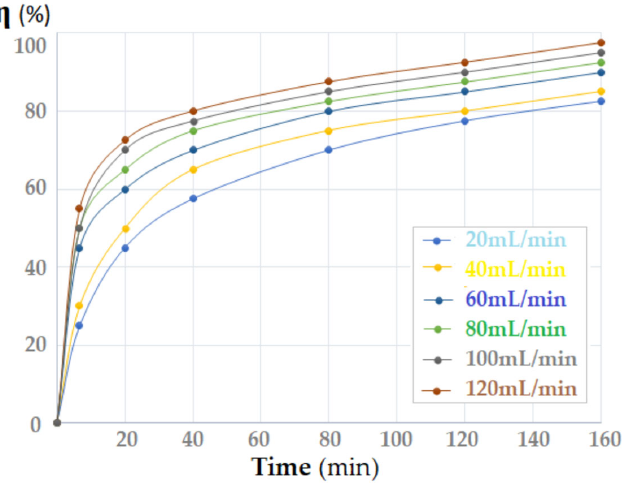
Figure 12. The variation in p –nitrophenol conversion ( η ) depending on the flow rate of the source phase (1000 mL) and the contact time with the membrane phase, containing 1.0 g/L osmium nanoparticles (Os–NP).